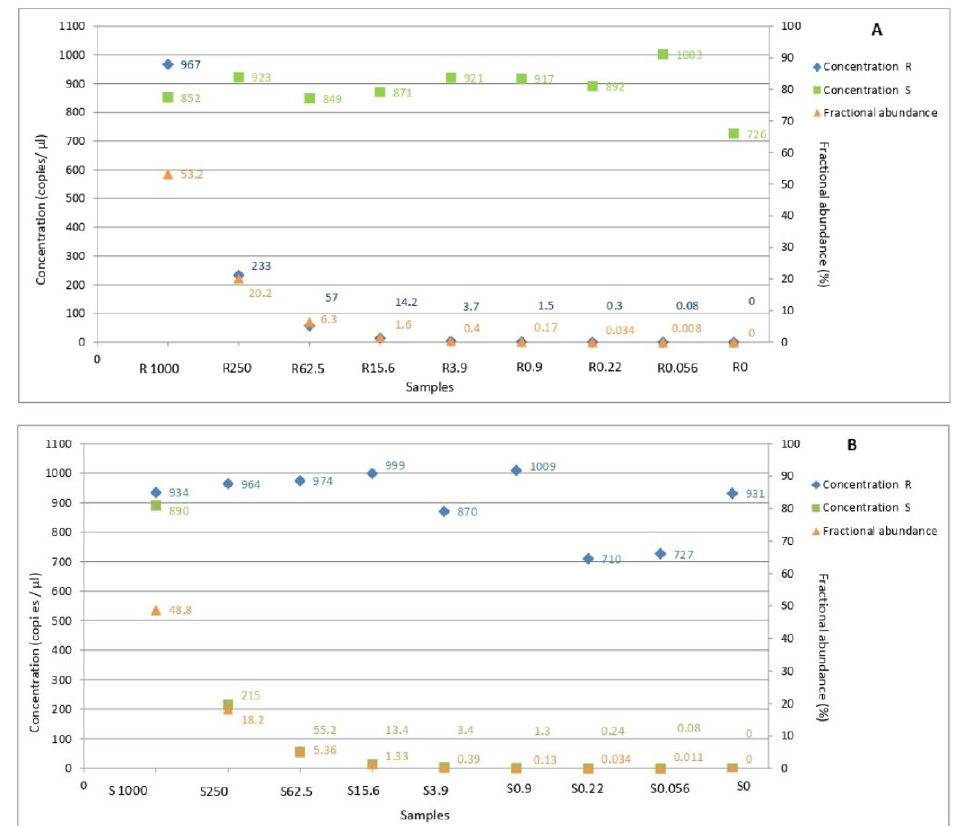
Figure 3. Values of concentration and fractional abundance of A143 and G143 alleles quantified in samples obtained by the mixture of gDNAs from A.1 and B.1 monoconidial isolates. A143 and G143 alleles are named in the graphic as R and S, respectively, and their copy numbers are represented by blue and green squares. ( A ) Samples from group 1: orange diamond represents the fractional abundances of A143 allele. ( B ) Samples from group 2: orange diamond represents the fractional abundances of G143 allele.